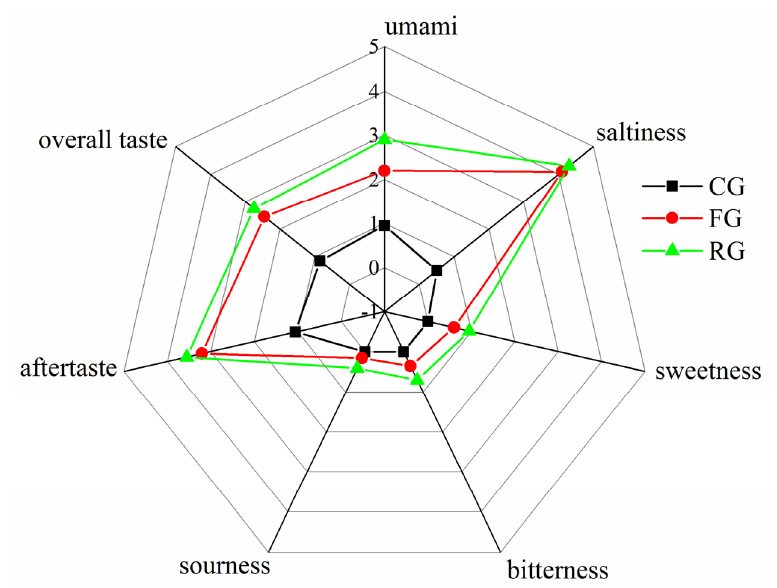
Figure 1. Taste performance of different period for dry-cured beef CG (control group), FG (fermented group), and RG (ripened group).